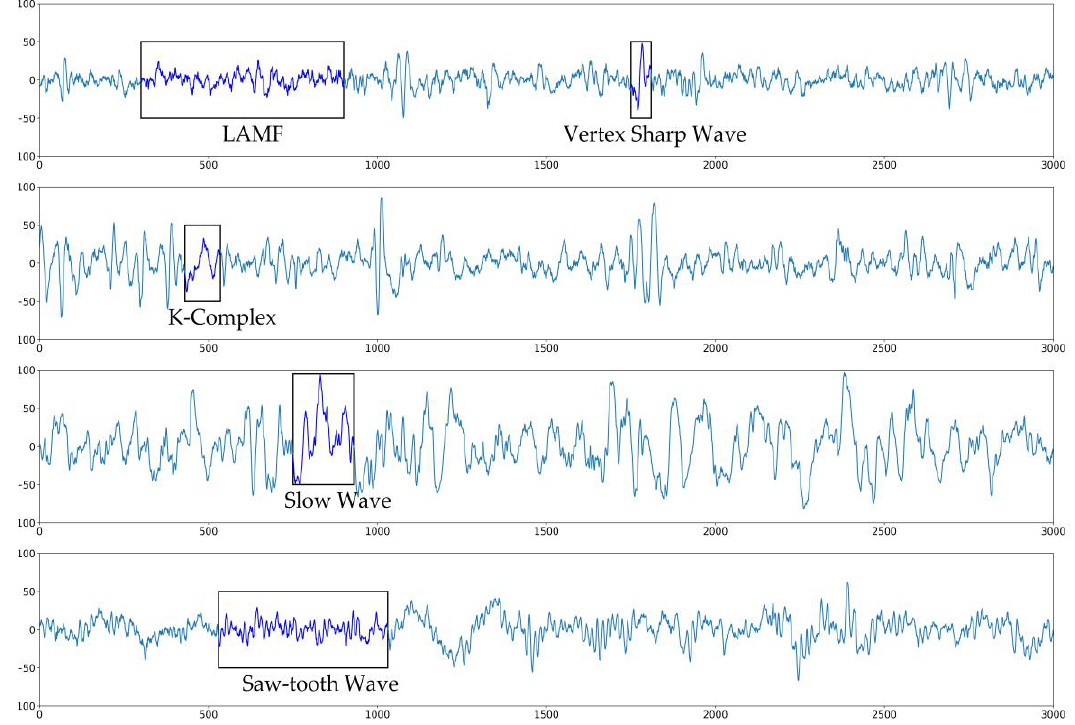
Figure 1. Examples of the characteristic electroencephalogram (EEG) signal features of sleep stages (from top to bottom): stage N1 with low amplitude mixed frequency (LAMF) and vertex sharp waves; stage N2 with K-complexes; stage N3 with slow waves; and rapid eye movement (REM) sleep stage with saw-tooth waves.